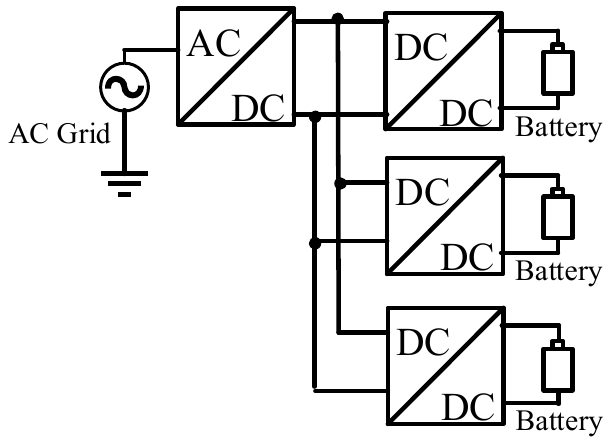
Figure 14. Structural diagram of multi-converter converter integrated systems.